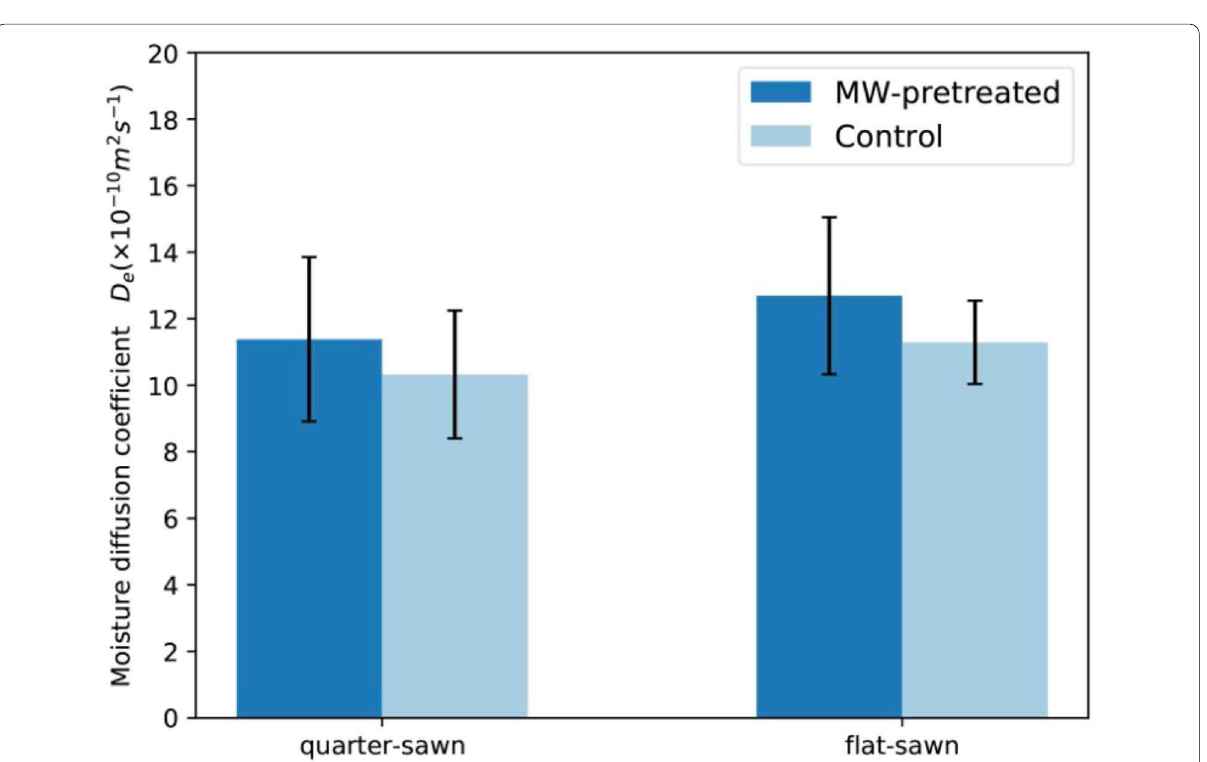
* Means significant at 0.05 level, — Means not significant at 0.05 level